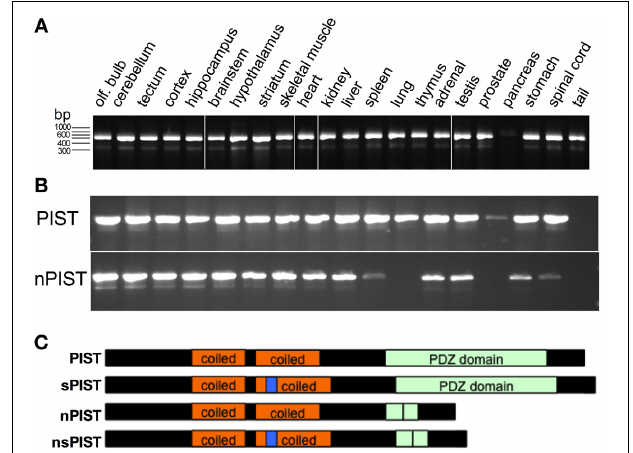
FIGURE 2 | New PIST isoforms. (A) PCR on cDNA from different mouse tissues show amplification of short (205bp) and a long (408bp) fragments corresponding to sPIST and PIST. (B) A PCR designed to differentiate neuronal and non-neuronalforms of PIST detect both short and long bands revealing the widely extended expression of both forms. (C) Schematic representation of the domains of all four PIST isoforms. Coiled-coil regions are depicted in orange, the insertion in n-PISTs in the second coiled-coil is represented in blue. The PDZ domain is represented in green, and a vertical line represents the site of deletion of exon